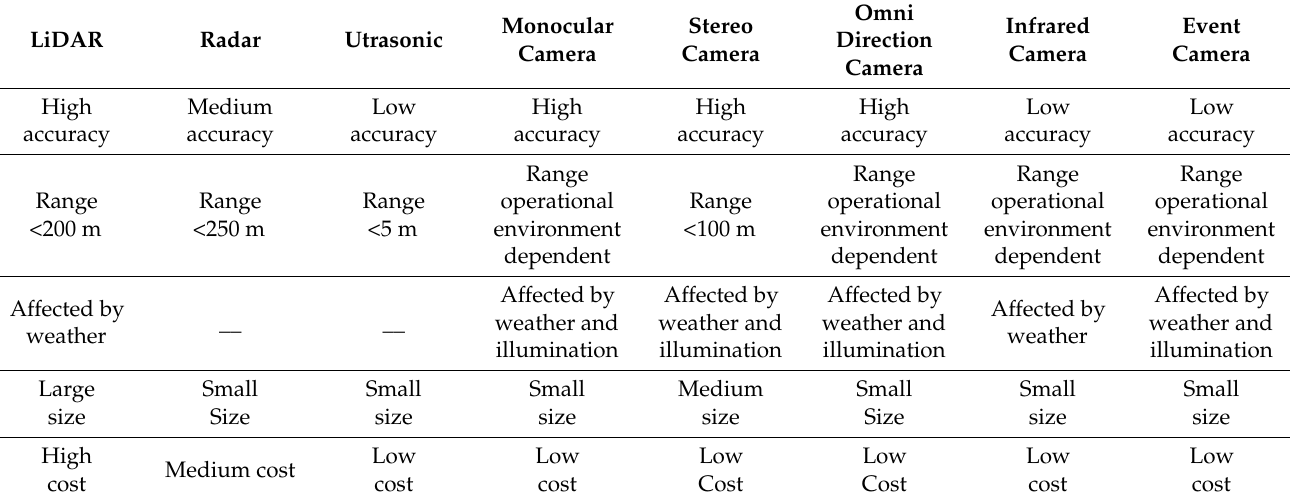
Table 3. Characteristics of exteroceptive sensors